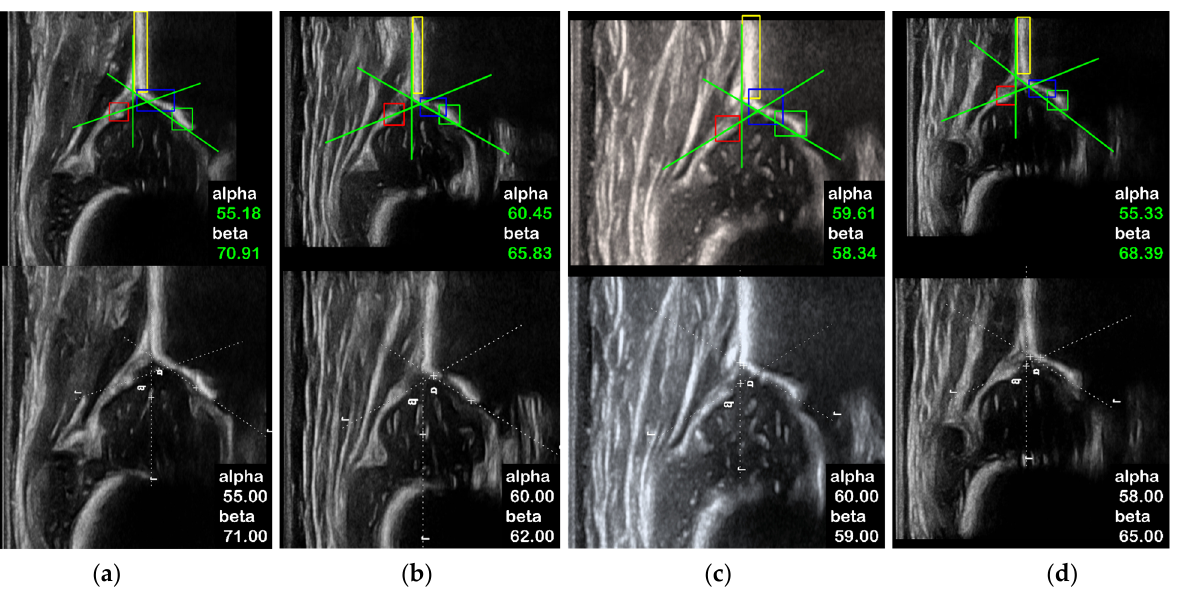
Figure 9. Qualitative comparisons on the angle measurement between the DM w. SPSM ( upper ) and sonographers ( lower ). The standard plane frames selected from the same US video are usually different, but the planes selected by DM w. SPSM and the angle measurement results are also reliable. The absolute differences between DM w. SPSM and sonographers are ( a ) Δα = 0.18°, Δβ = 0.19°; ( b ) Δα = 0.45°, Δβ = 3.83°; ( c ) Δα = 0.39°, Δβ = 0.64°; ( d ) Δα = 2.67°, Δβ = 3.39°.